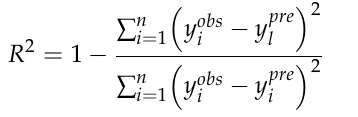
stone column length to its diameter, ranging from 2 to 8; the ratio of the length of the en- casement to the diameter of the stone column, ranging from 0 to 8; and the shear strength of unreinforced clay, varying between 3.86 and 53.82 kPa. Moreover, the meas- ured bearing capacity of the composite soil also demonstrated a wide range of values, falling between 14.11 and 467.01 kPa. The wide range of potential values for both input and output variables in the dataset highlights the diversity of the samples included and the abil- ity of the models constructed with this data to be applicable to a wide range of scenarios. 4. Model Results 4.1. K-Fold Cross-Validation The training performance of each ML model is depicted in the boxplots in Figure 3 using the R 2 and RMSE metrics. The boxplots show the variability and fluctuations of the performance measures by using 5-fold cross-validation on 197 actual values from the training data sets. The five-number summary of a dataset, consisting of the minimum, first quartile, median, third quartile, and maximum values, is graphically displayed in a box plot, also known as a box-and-whisker plot. These values are represented in the box plot by a box that spans from the first quartile to the third quartile and a line inside the box that represents the median. The box plot also includes “whiskers” that extend from the box to the minimum and maximum values and diamonds that represent any values that fall outside of the whiskers. Specifically, outliers are any data points that are higher